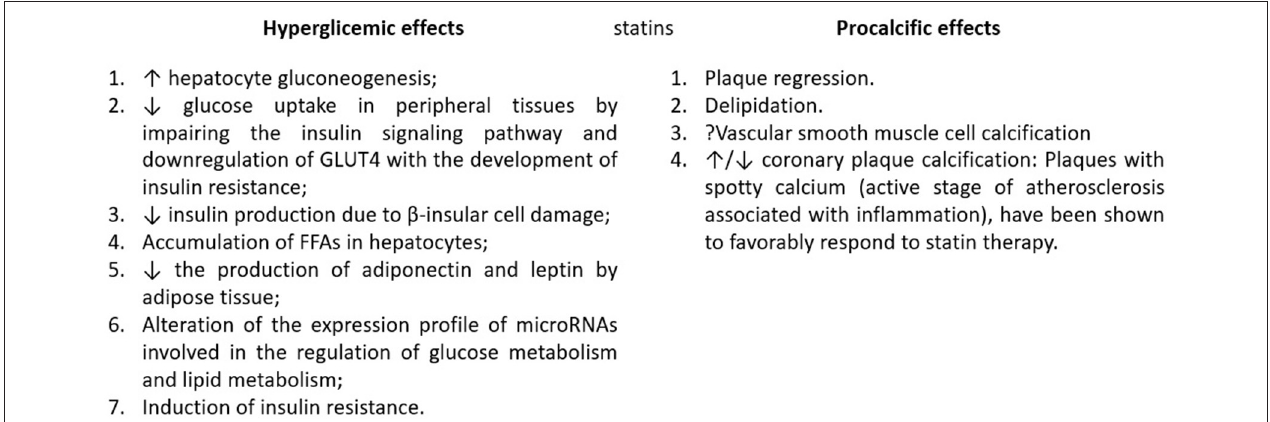
FIGURE 2 | Statin mechanisms for hyperglycemia and procalcific effects. Natural plaque progression likely involves lipid-pool expansion coupled with microcalcifications within lipid pools. Following long-term high-intensity statin therapy, plaque regression manifests as delipidation and probable vascular smooth muscle cell calcification, promoting plaque stability. GLUT4, Glucose transporter type 4; FFA, free fatty acids. Adapted from: (